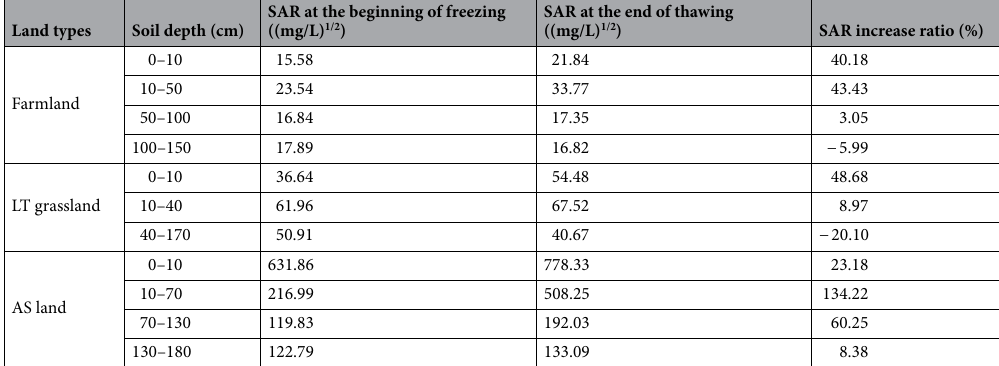
Table 4. Soil SAR increase ratio of farmland, LT grassland and AS land in freeze–thaw processes.